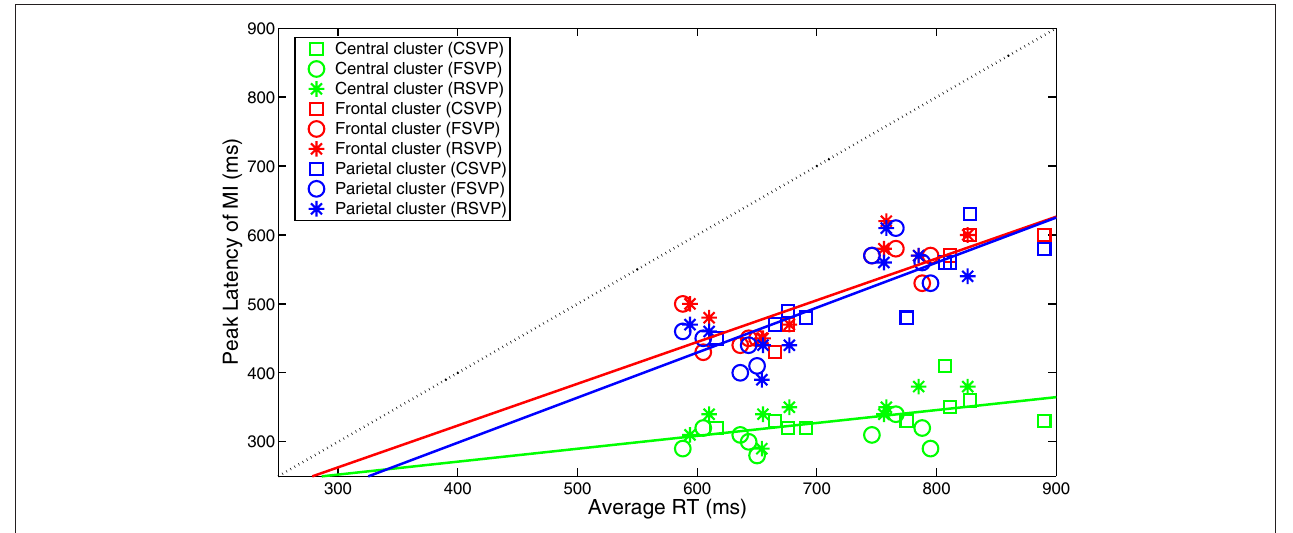
FIGURE 6 | Nine subjects’ peak latencies of mutual information as a function of their average response times and for each